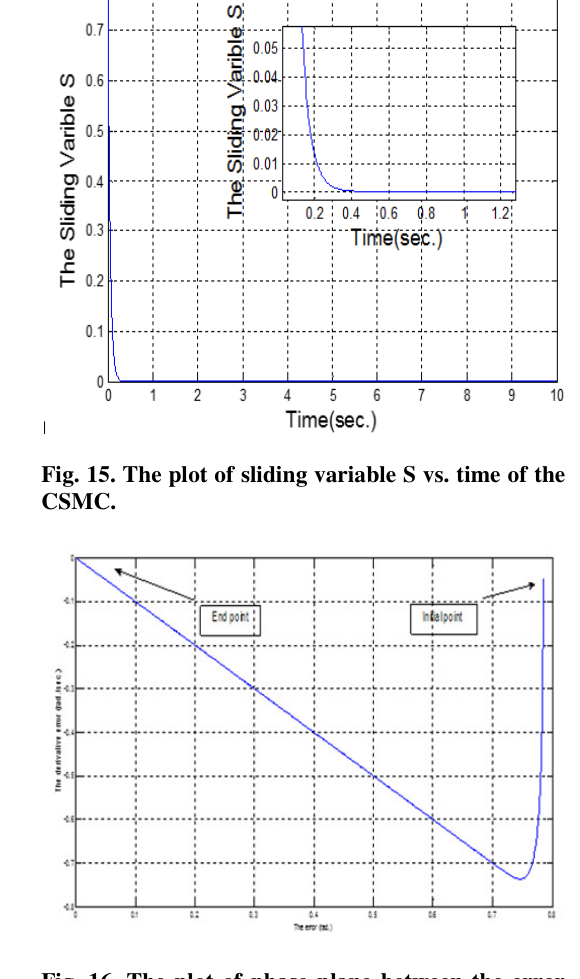
Fig. 13. The derivative error _ CSMC.